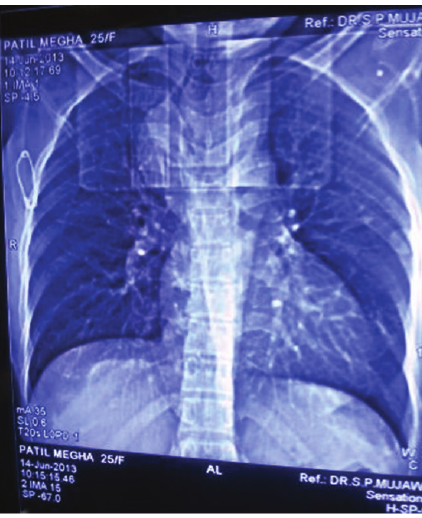
Figure 1: Chest X-ray showing opacity along right paratracheal region.